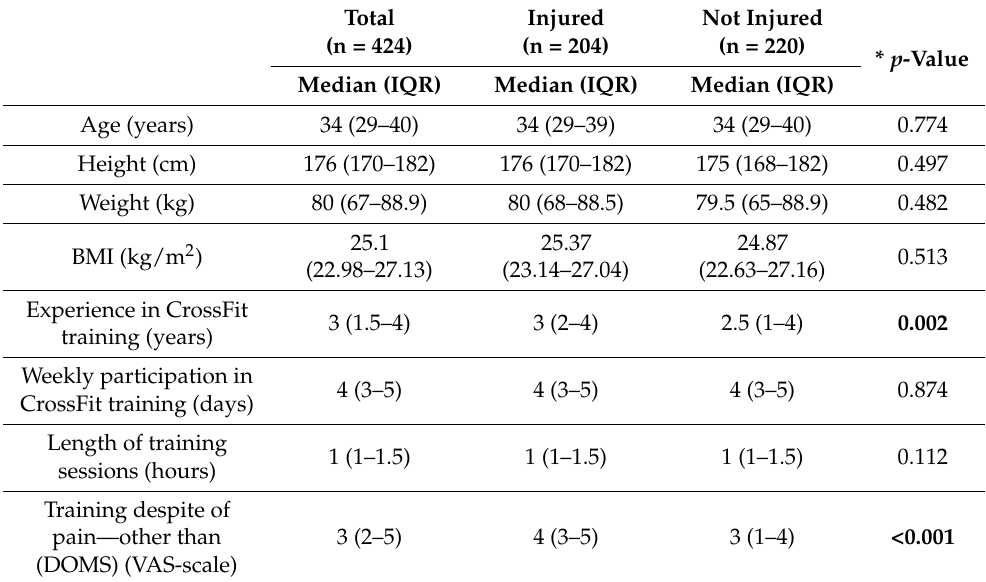
Table 1. Demographic profile per